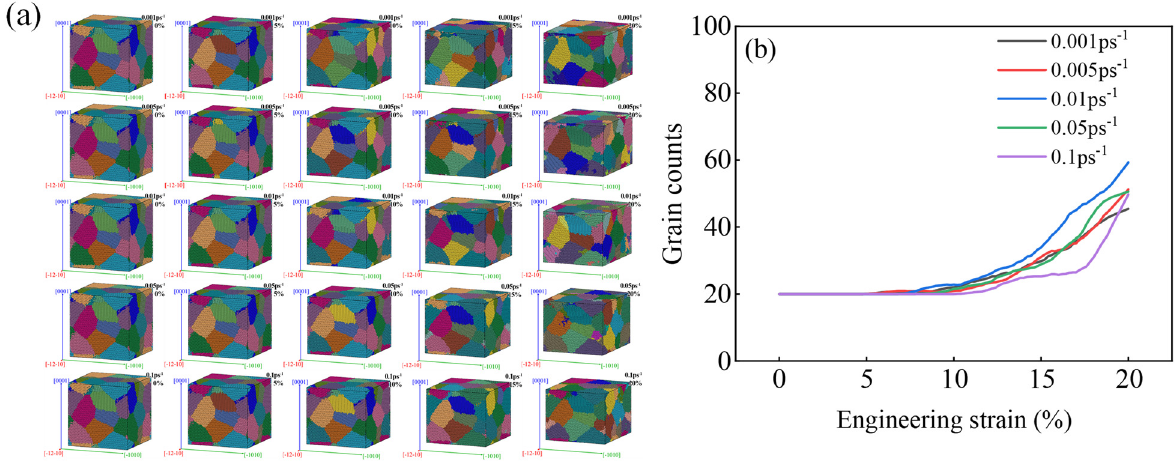
Figure 17: Grain evolution: ( a ) grain diagram and ( b ) grain